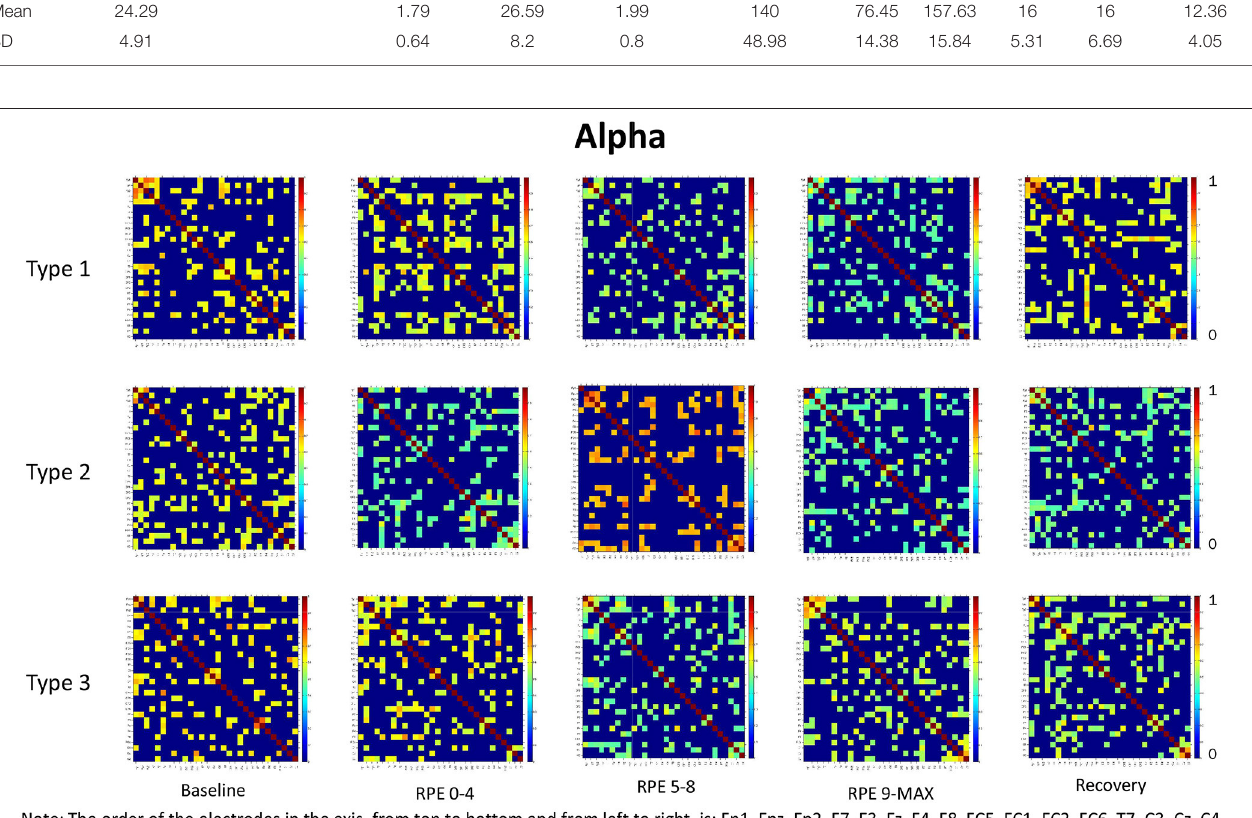
FIGURE 1 | Coherence matrices for each type of performance during different time periods of the protocol in the alpha band. Red color indicates high values of coherence whereas the blue color indicates low values of coherence.